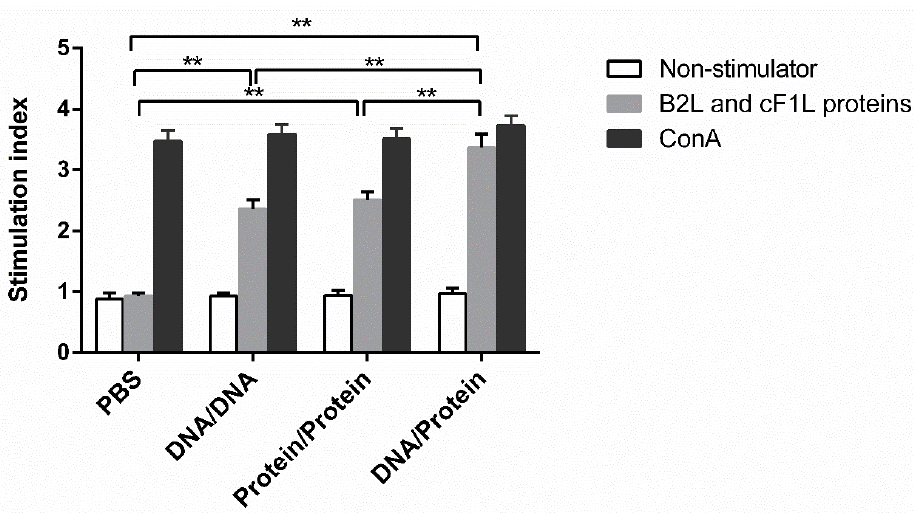
Figure 5. Splenic lymphocyte proliferation reaction of mice in each group two weeks after enhanced immunization. Splenocytes were isolated 14 days after the boost immunization and stimulated with B2L and cF1L proteins. Lymphocyte proliferation response was measured and expressed as the stimulation index (SI). Stimulation index SI = OD experimental group-OD background /OD negative control group-OD background. Each group of data is expressed as mean ± standard error ( n = 5), ** p < 0.01.